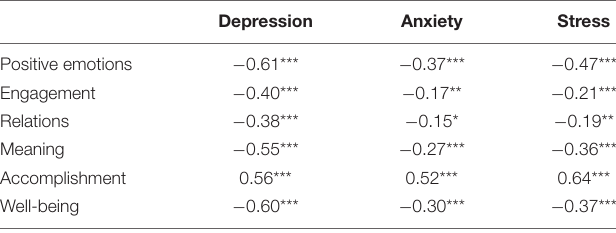
TABLE 2 | Pearson correlations between the results of the DASS-21 and PERMA scales.